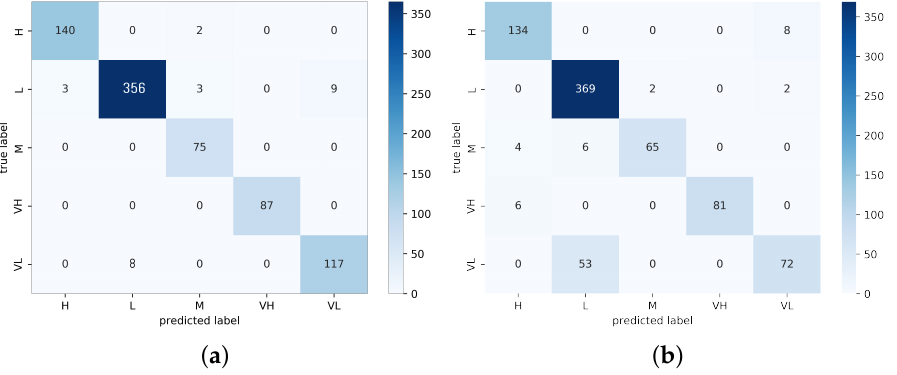
Figure 13. Confusion matrix heat map of UMN Plaza 2 for ( a ) MCMS-BCNN-Attention+densenet121 and ( b ) MCMS-BCNN-Attention+Efficientnetv2.